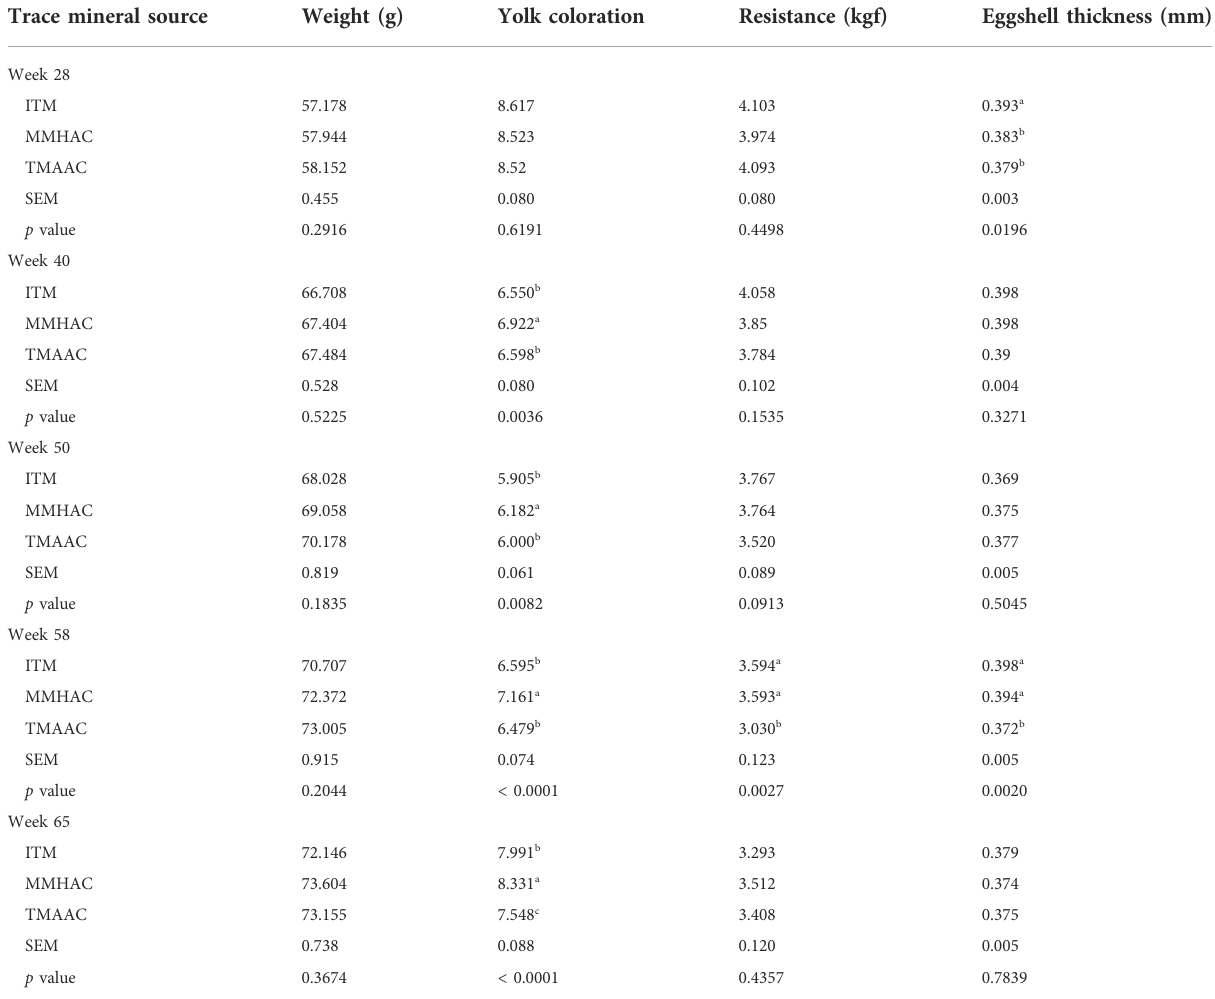
TABLE 7 Effect of inorganic or organic trace minerals on egg quality parameters of broiler